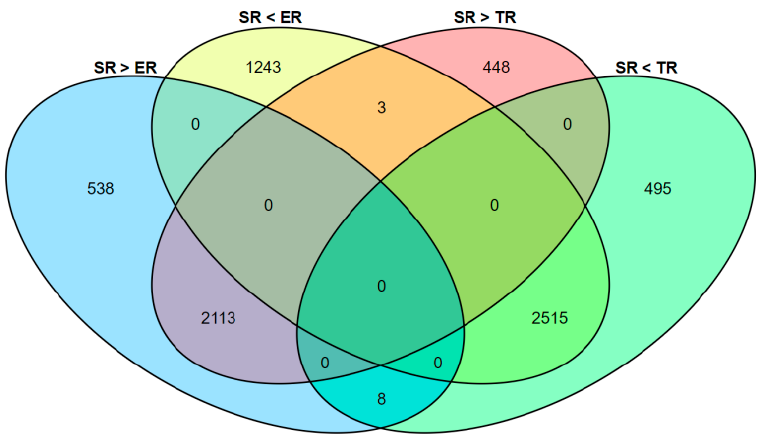
Figure 15. Venn diagram showing DEGs of SR samples compared with ER and TR groups. ER, elongation region; TR, transition region; SR, stable region.